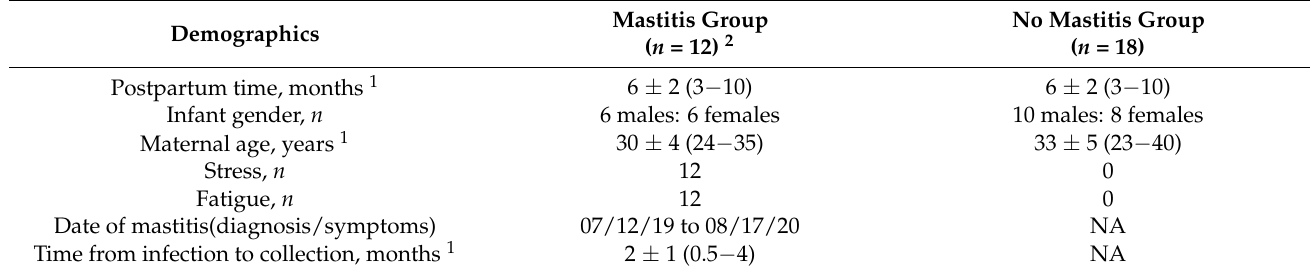
Table 2. Demographic description (self-reported) of mothers with mastitis and mothers without